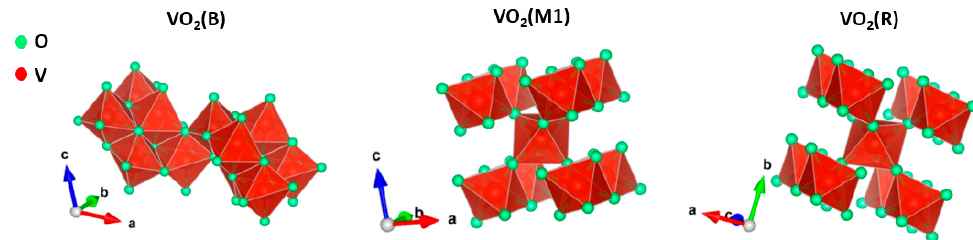
Figure 5. Comparison between the structures of VO 2 (B), VO 2 (M1), and VO 2